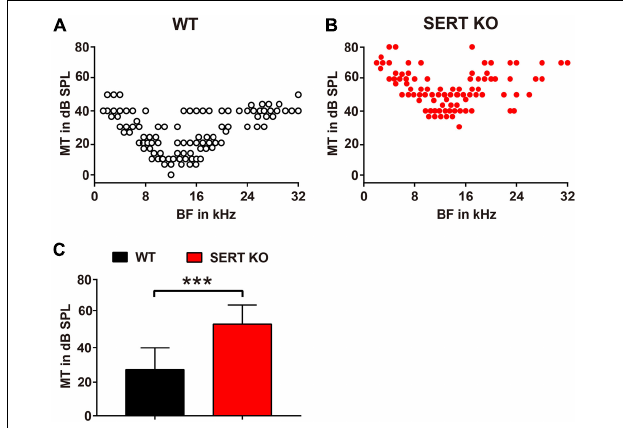
FIGURE 5 | Serotonin transporter (SERT) knockout (KO) elevates the threshold of neurons in primary auditory cortex. Pooled data show minimum thresholds at the best frequency of auditory neurons recorded from the A1 region of wild-type (WT) (A) and SERT KO mice (B) . WT: n = 6, recording site = 246. SERT KO: n = 6, recording site = 243. (C) The average minimum threshold (MT) of neurons in SERT KO mice was significantly higher than that in WT mice. Data are means ± SD. *** p < 0.001. Student’s t